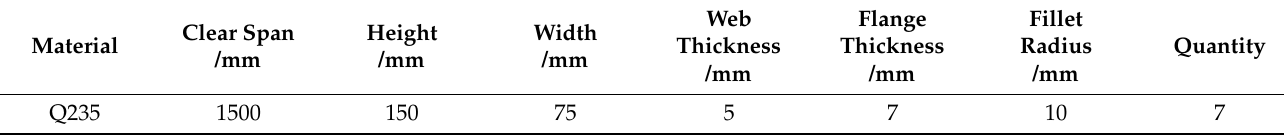
Table 1. The detailed specifications of the test beam